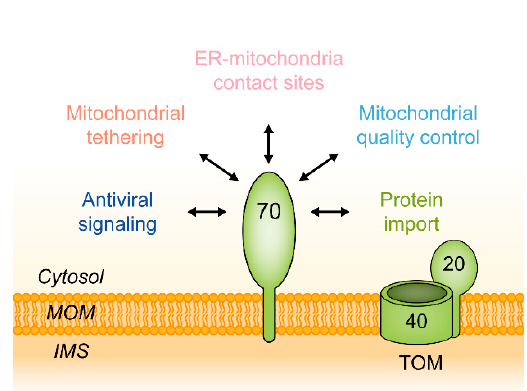
Figure 1. Cellular functions of the mitochondrial outer membrane protein Tom70. IMS, intermembrane space; MOM, mitochondrial outer membrane; TOM, translocase of the mitochondrial outer membrane, containing the channel-forming protein Tom40 and the import receptor Tom20.